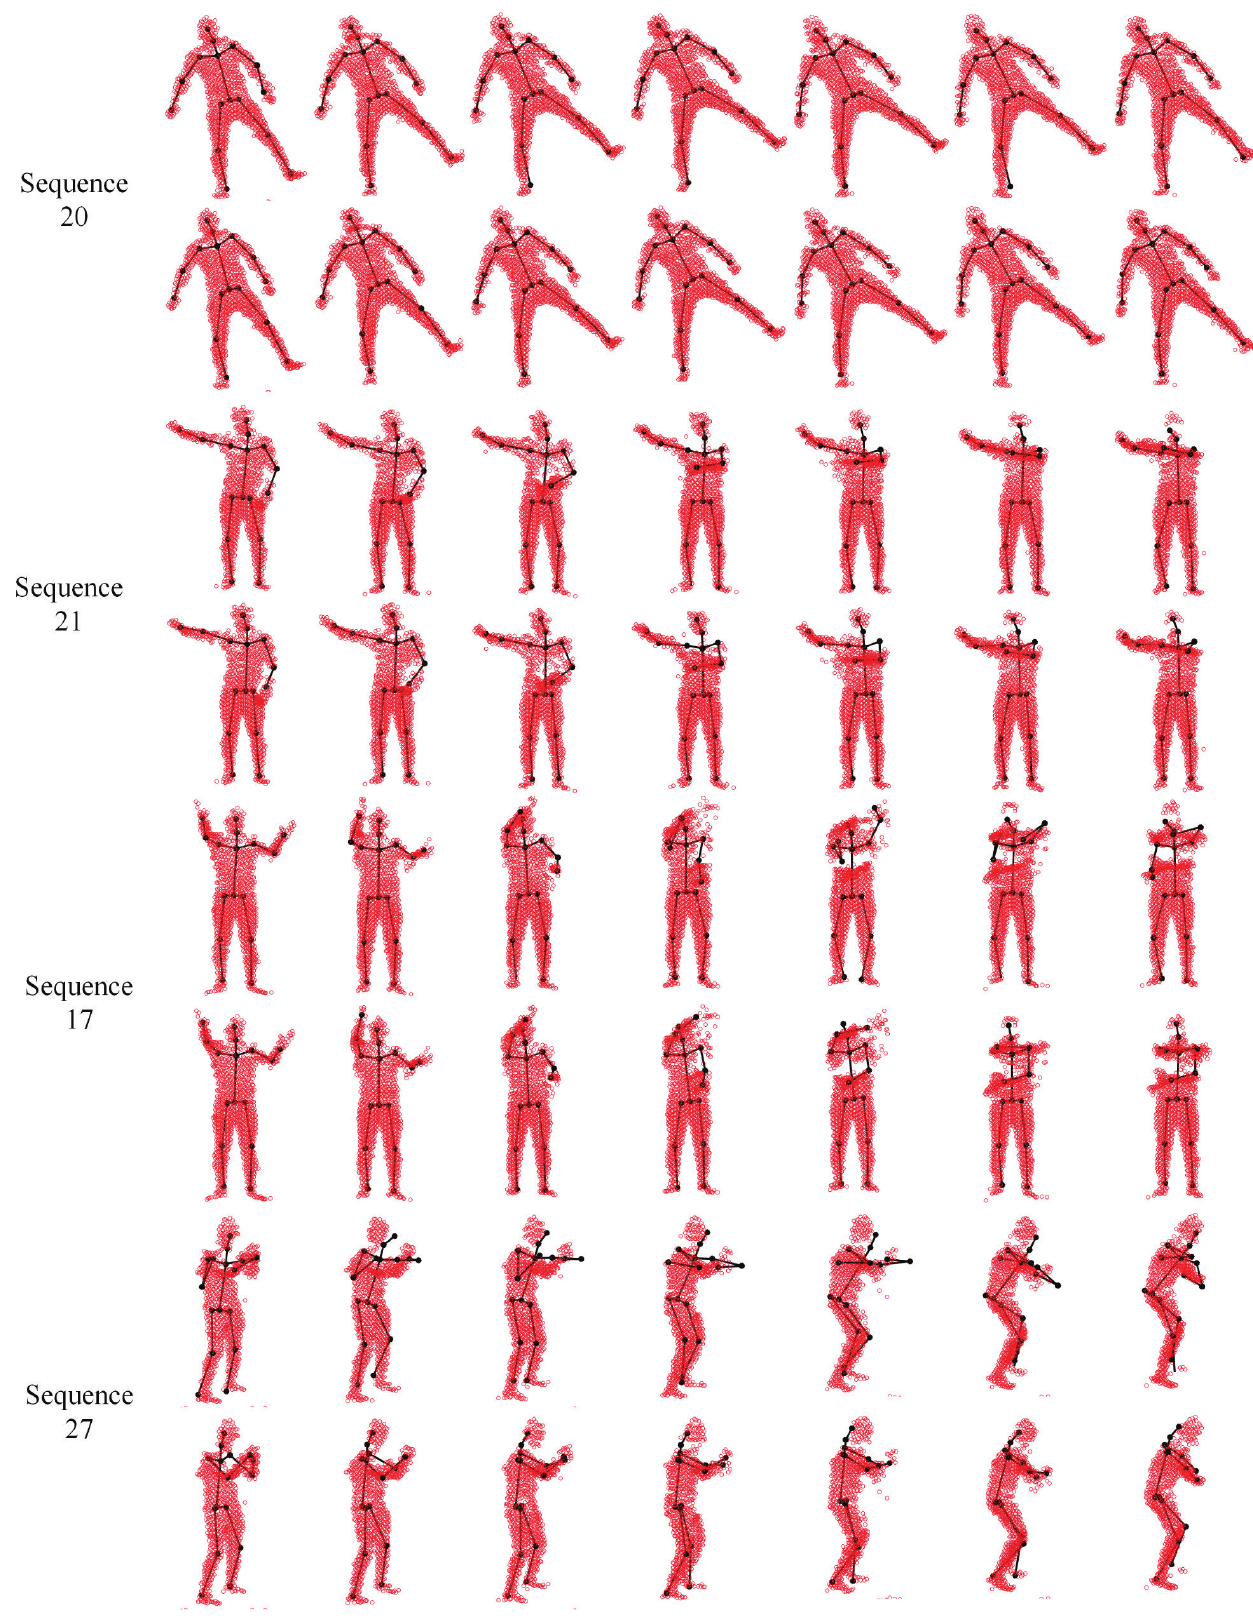
Figure 21. Pose estimation results for four SMMC-10 sequences. For each sequence, the first and second rows show the results without tracking and those with tracking,